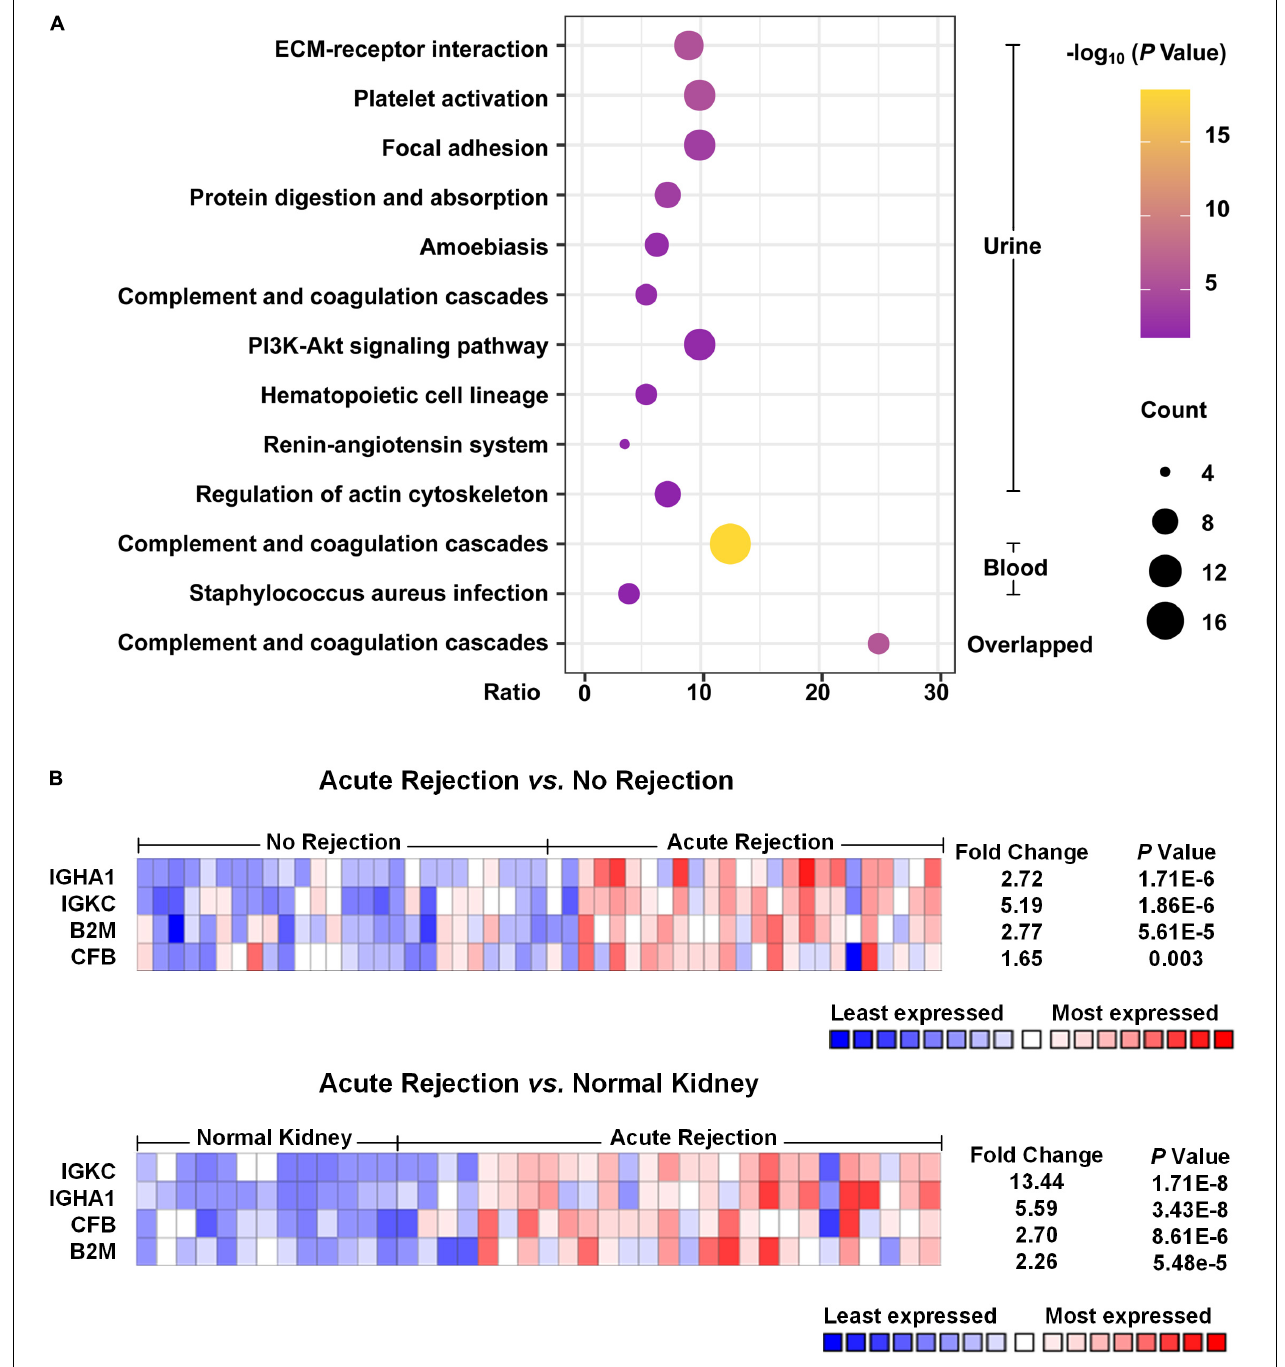
FIGURE 2 | Pathway enrichment analysis and Nephroseq usage. (A) Pathway enrichment analysis of the DEPs was performed with DAVID. The top 10 pathways of urinary DEPs are shown. As for analysis of the DEPs from blood samples, only two pathways were identified with an adjusted p -value < 0.05. (B) Heat map of the expression of potential biomarkers based on Nephroseq. Compared with non-rejection and normal kidney tissue groups, acute rejection showed that IGKC, IGHA1, B2M and CFB were significantly different with a p -value < 0.05 and fold change > 1.5.